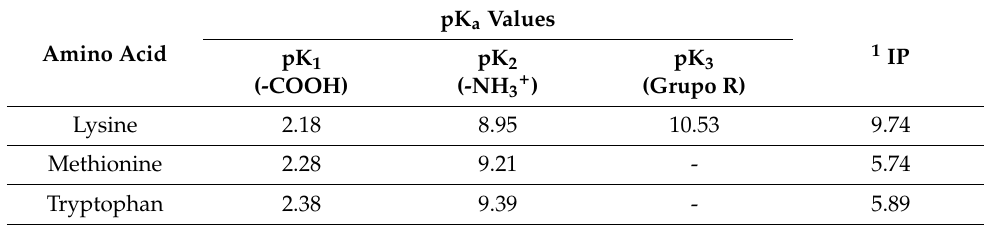
Table 1. The pka and isoelectric point values of lysine, methionine, and tryptophan.